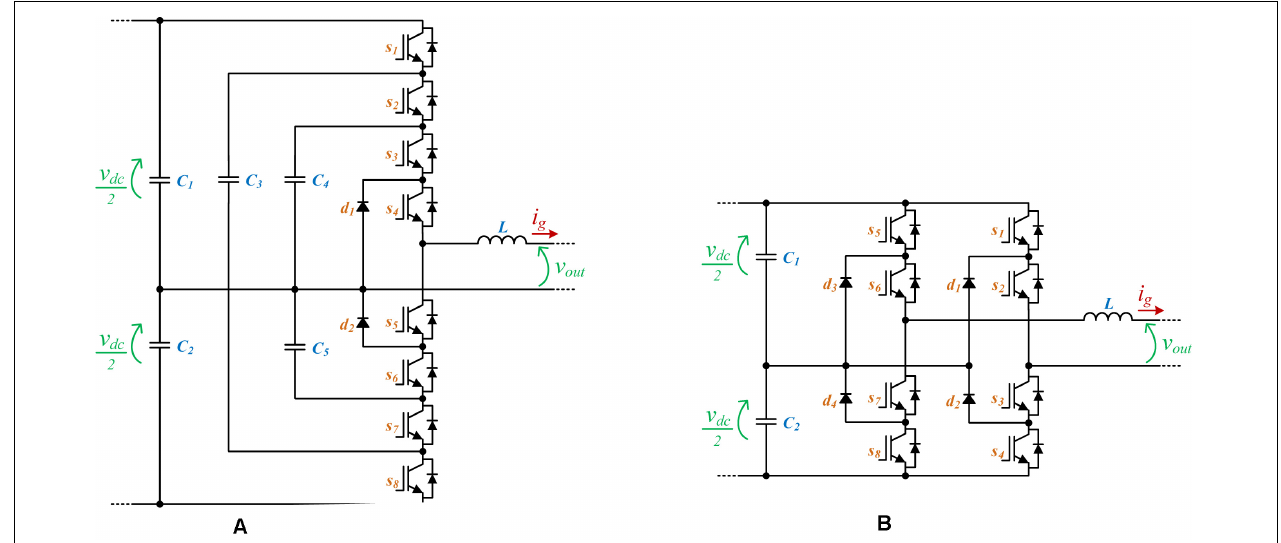
FIGURE 8 | Topologies: (A) proposed in Narimani et al. (2016); (B) proposed in Aly et al. (2018).